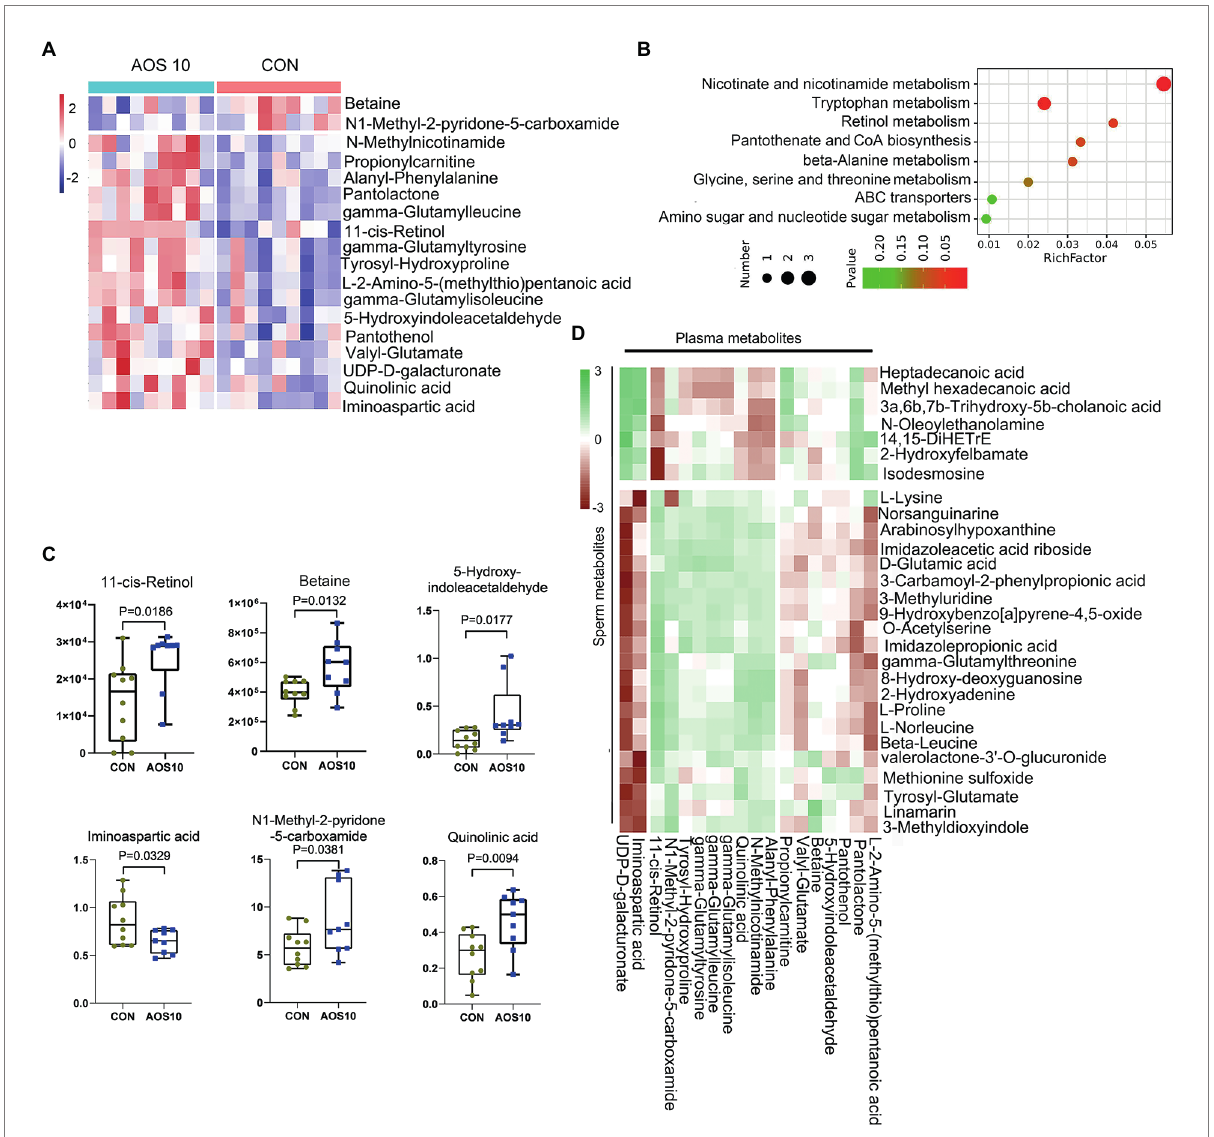
FIGURE 4 The effects of AOS on boar blood metabolome. (A) Heatmap of changed blood metabolites. The blood metabolites were determined by LC–MS/ MS. (B) KEGG enriched pathways of changed blood metabolites. (C) List of AOS changed blood metabolites. Y-axis = relative abundance, X-axis = treatment group (mg/kg body weight). (D) Correlation of blood metabolites and sperm